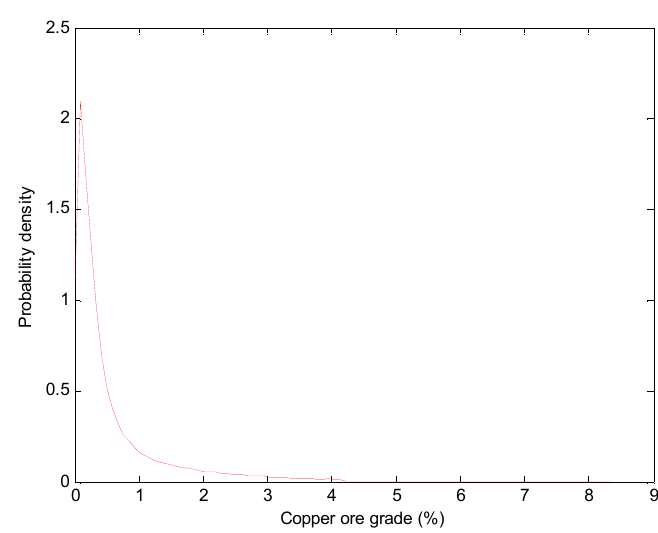
Figure 8. Probability density of the copper ore grade distribution.